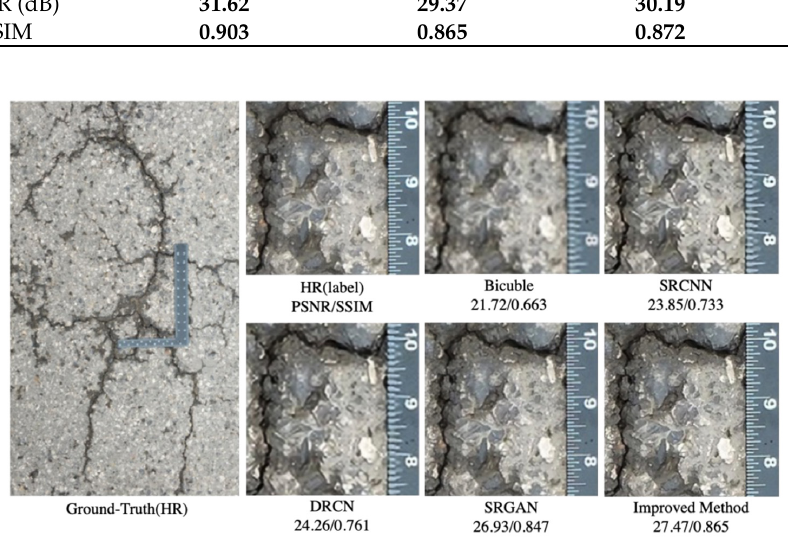
Figure 9. Reconstruction results